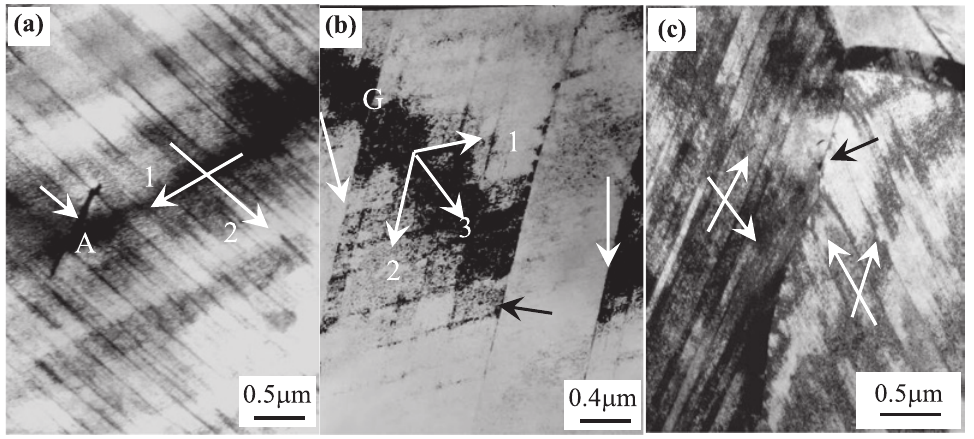
Fig. 4: Deformed features of GH4169 alloy after tensile fracture at different temperature. (a) Stretching at 20 °C, (b) stretching at 500 °C, (c) stretching at 650